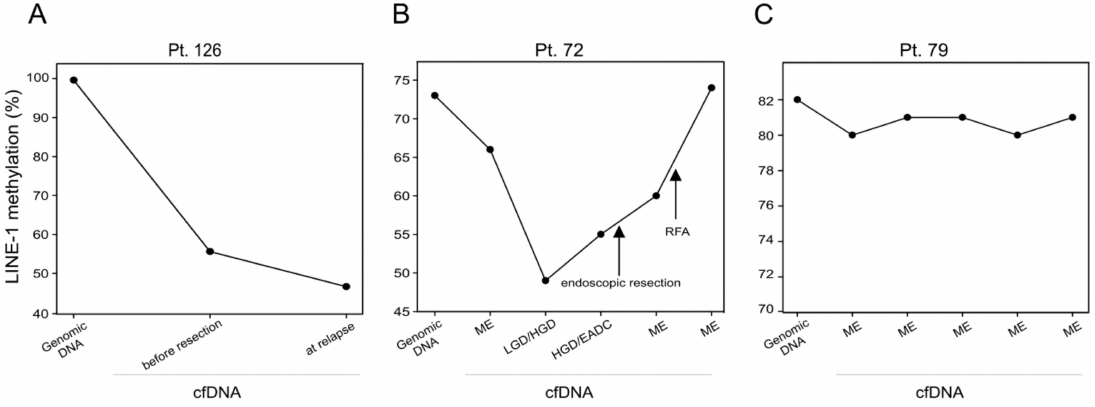
Figure 6. LINE-1 methylation level in longitudinal studies of a EADC patient ( A ), of a